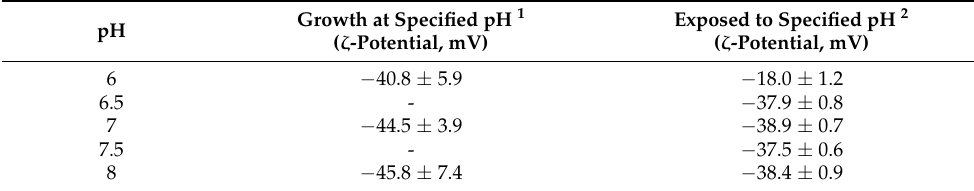
Table 1. Zeta-potential of V. fischeri grown under different pH conditions.